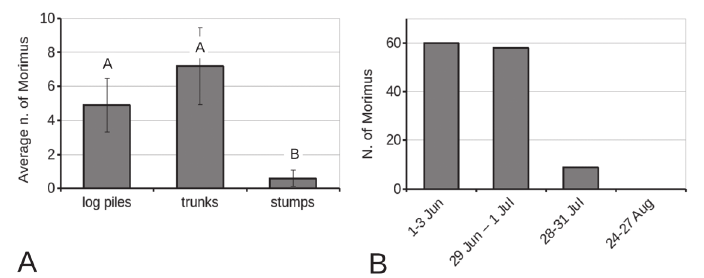
Figure 9. A Average numbers of M. asper observed on different structures in 2015 at Prealpi Giulie. Error bars represent standard errors B Total number of M. asper observed during different periods in 2015 at Prealpi